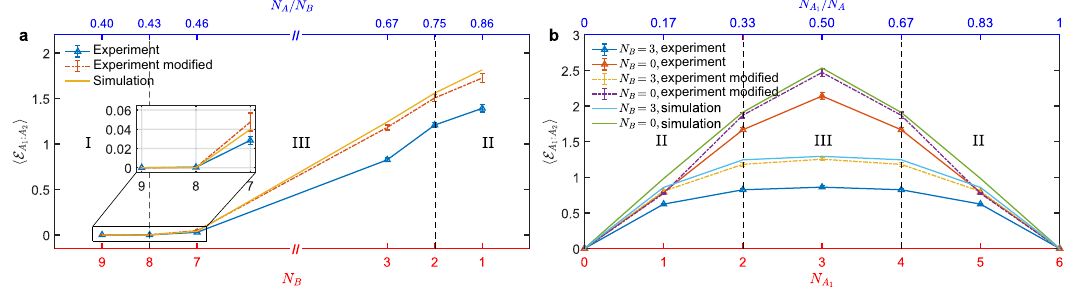
Fig. 3 | Averaged logarithmic negativity h E A dard error of the mean over circuit instances. a Fix N A decrease N B from9to1. b Fix N B = 3or0andincrease N A